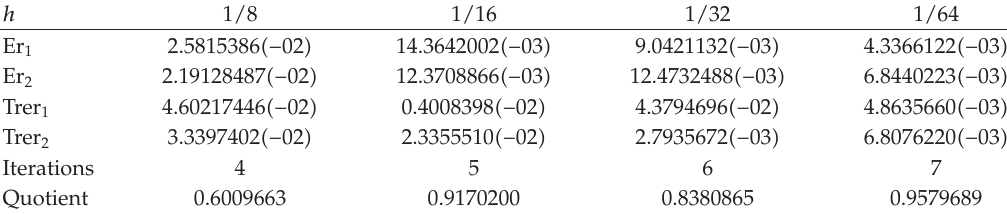
Table 6: Results on the L -shaped region with a posteriori estimates as a stopping